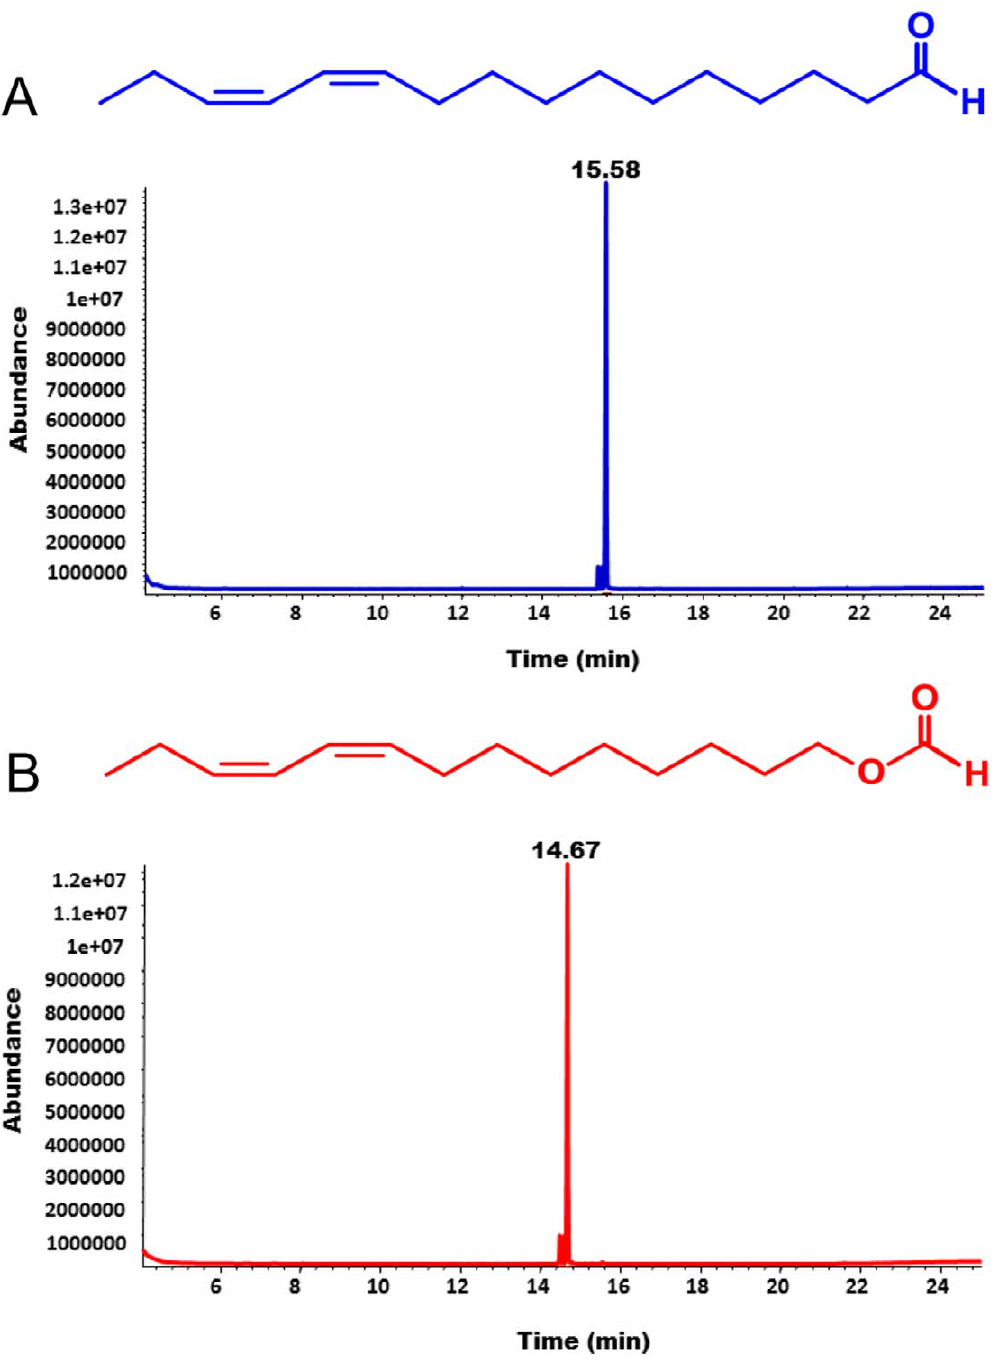
Figure 6. Total ion-chromatograms. Representative traces obtained with the main constituent of the sex pheromone (blue trace) and its related formate (red). Small peaks eluting just prior to the main peaks are stereoisomers of sex pheromone and parapheromone.